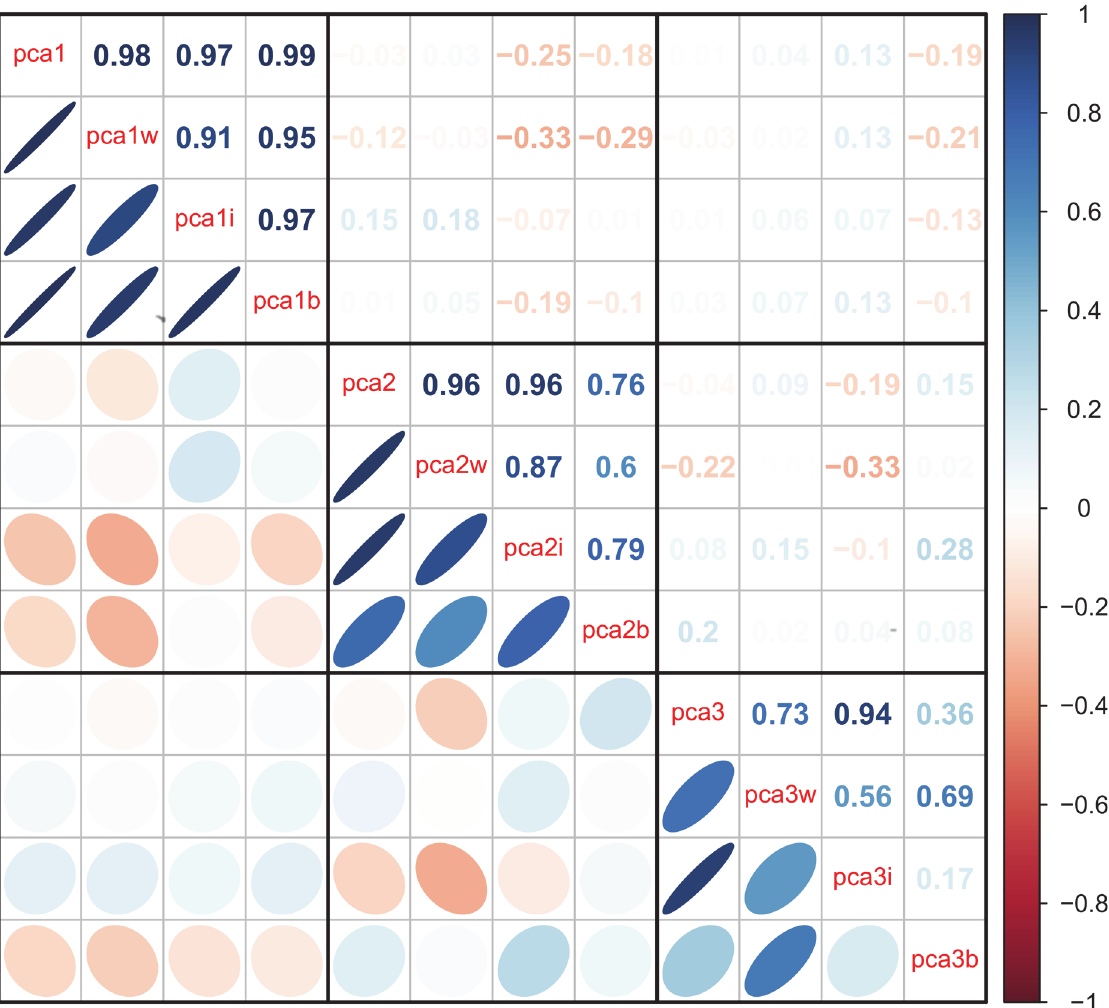
Fig 3. Correlations among the first three PCA axes ( “ pca1 ” , “ pca2 ” , and “ pca3 ” ). Correlations were calculated from the full merged 43-variable data set or from each of the separate data sets (WHAS: w; InCHIANTI: i; BLSA: b). The loadings from each subset-based PCA are reapplied to the full data set to calculate the scores used in the correlations. Ellipses below the diagonal indicate correlations visually: blue when positive, red when negative, and darker and narrower when stronger. Correlation coefficients are above the